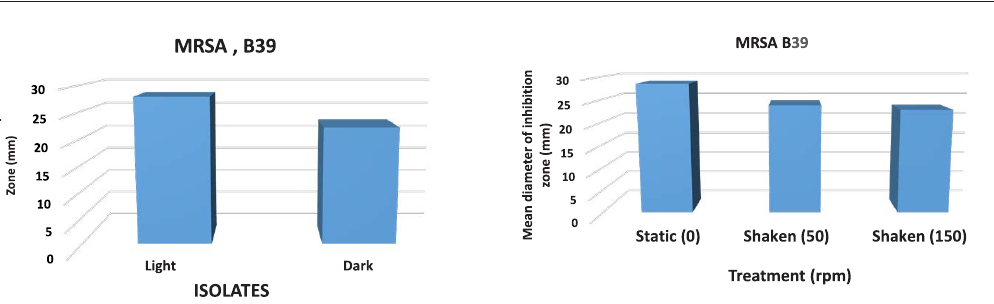
Fig. 2-a . Antimicrobial activity of mixture of ethyl acetate extracts of P. plebeium,( PP) and E. hirta ( EH) against MRSA B39 in relation to dark and light.